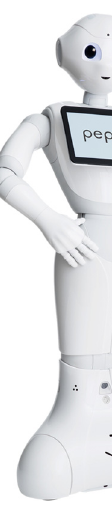
Figure 4: Softbank ’ s Pepper